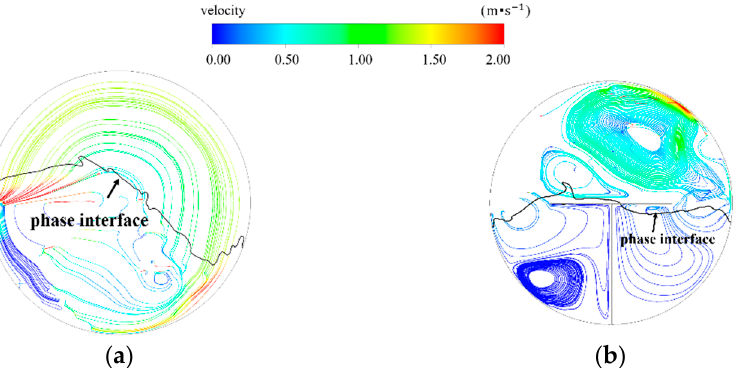
Figure 16. Flow diagram with T-shaped baffle vs. non-baffle (LR = 50%, t = 1 s). ( a ) non-baffle; ( b ) baffle with HR = 0.5.